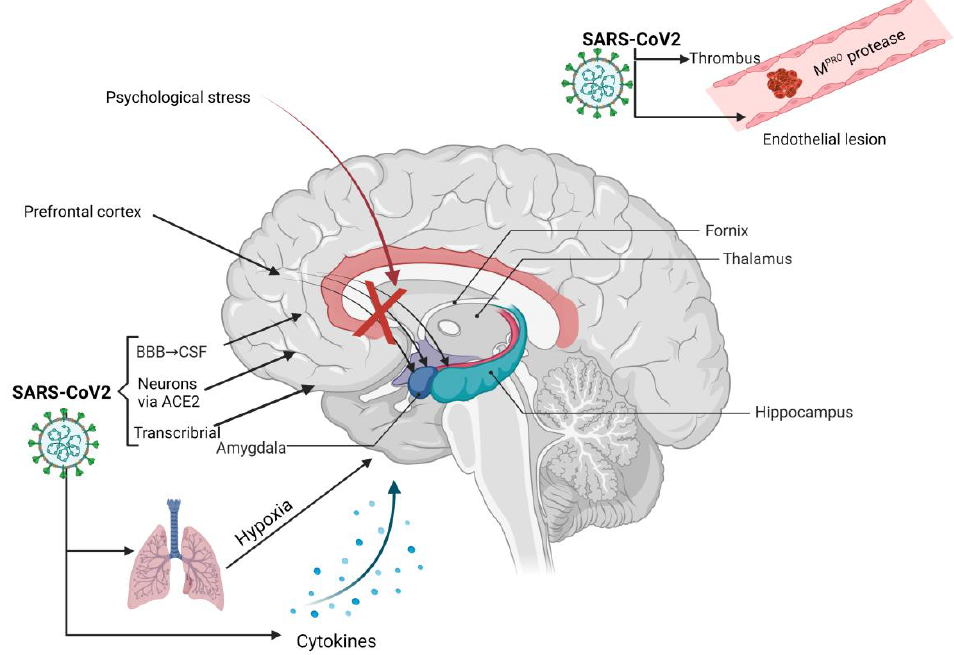
Figure 1. Main mechanisms involved in brain injury following COVID. BBB — blood – brain barrier, CSF — cerebrospinal fluid, ACE2 — angiotensin-converting enzyme 2 receptor.